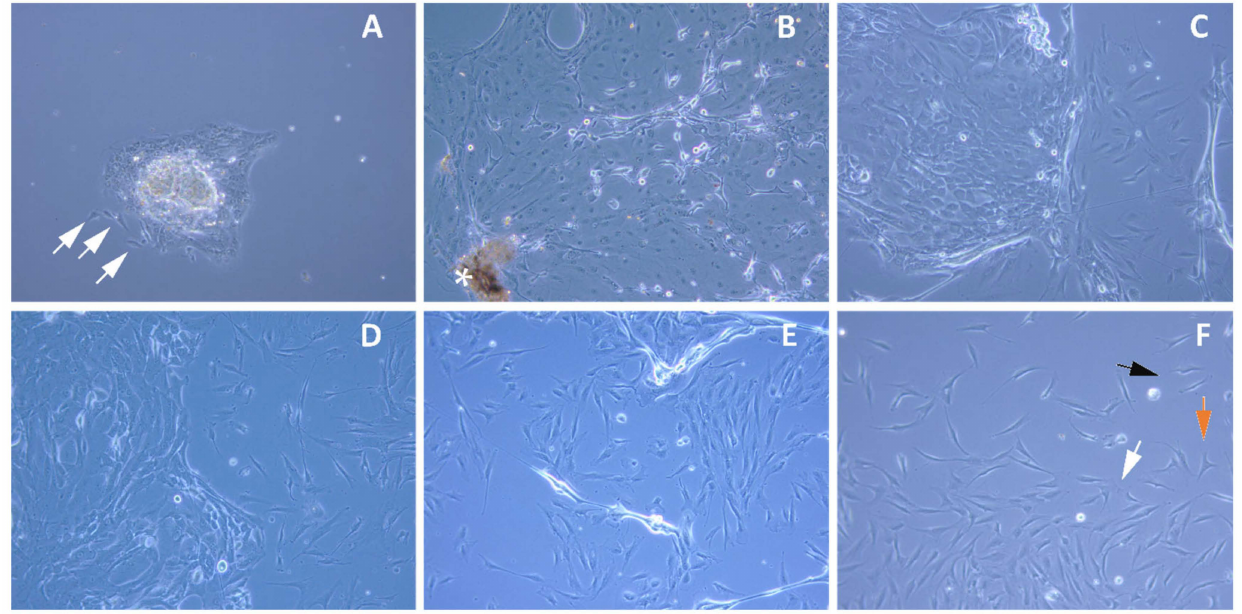
Figure 1. Expansion of the limbal stem cells in culture. Representative images of the limbal stem cells in the primary culture: initiation ( A ) and at confluence ( B , C ), passage P1 ( D ), passage P2 ( E ) and passage P3 ( F ). Epithelial cells (round morphology) and stromal/progenitor cells (spindle morphology, indicated with white arrows) derived from the limbal explant ( A ). Gradual increase in limbal stromal cells population and simultaneous fading of limbal epithelial cells ( C – E ). Pure population of the limbal stromal cells obtained in passage P3 including dendritic cells (( F ); black), undifferentiated myofibroblastic cells (( F ); orange), and quiescent fibroblastic cells (( F ); white); * Limbal